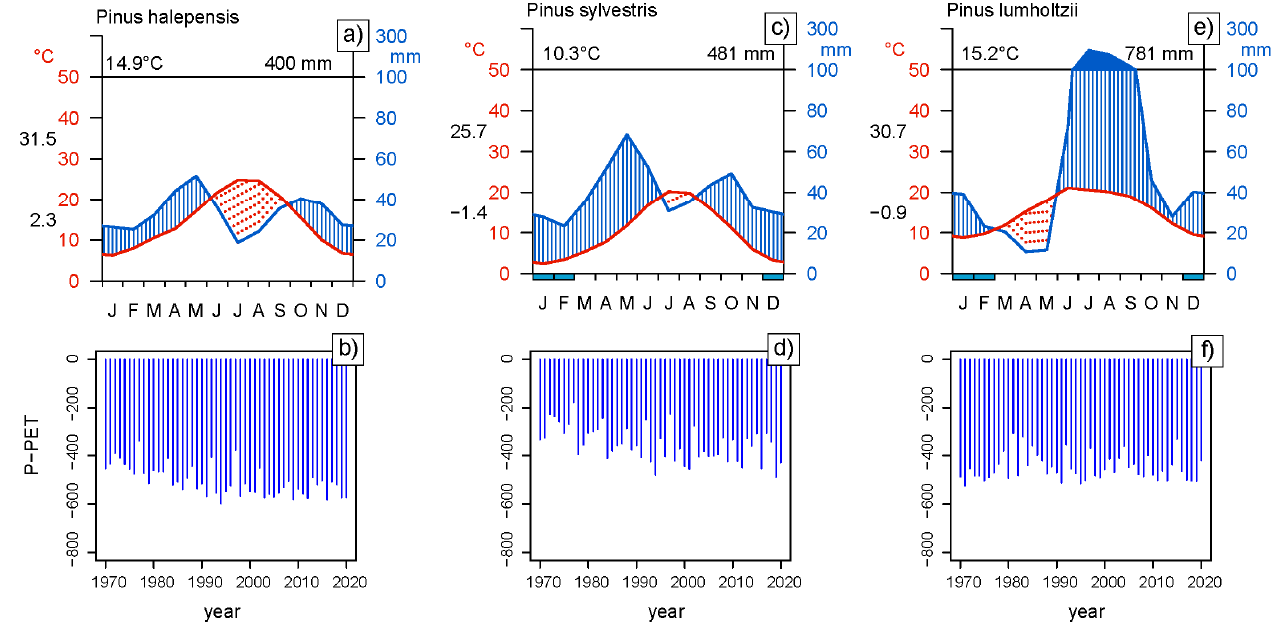
Figure 2. Climate characteristics at the study sites are based on the 1970–2020 period. Walter-Lieth climate diagrams for each site ( a , c , e ), and climate water balance (P-PET) values (in mm) for summer (JJA, June to August) for Pinus halepensis ( b ) and Pinus sylvestris ( d ) or spring (MAM, March to May) for Pinus lumholtzii ( f ). In the in the climate diagrams, monthly precipitation below 100 mm is scaled 2:1 with mean monthly temperature (vertically hatched) and above 100 mm 15:1. Turquoise bars below the x-axis show the months where frosts can occur (when absolute monthly minimums are equal or lower than 0 °C).